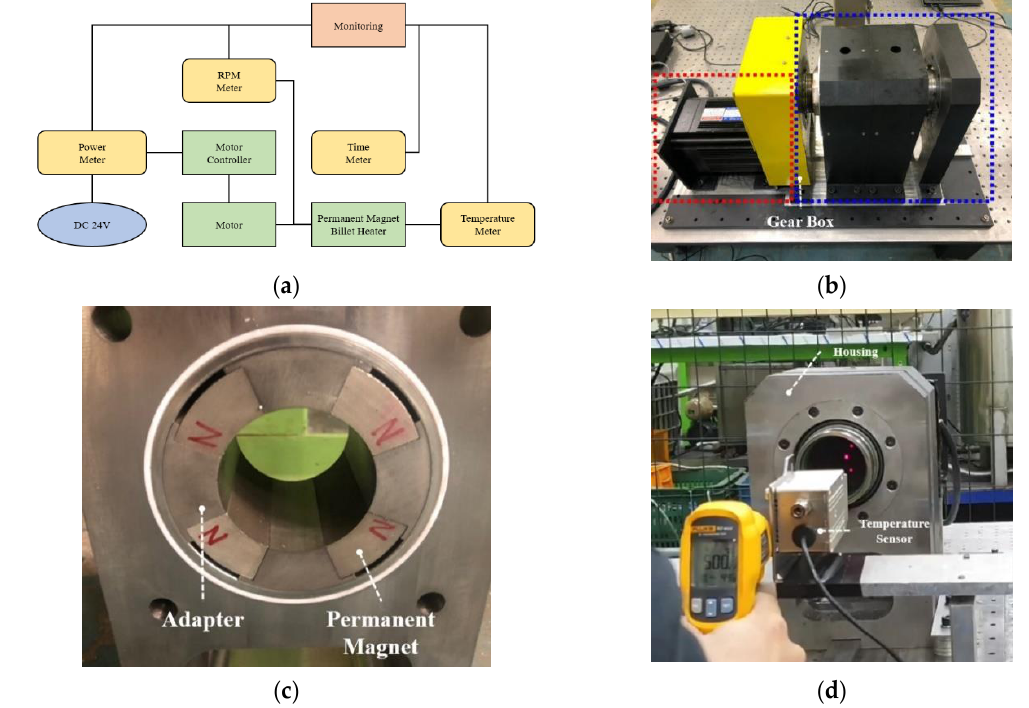
Figure 5. Experimental setup of the rotary induction heating system; ( a ) test scheme; ( b ) test bed; ( c ) permanent magnet arrangement; ( d ) temperature measurement.